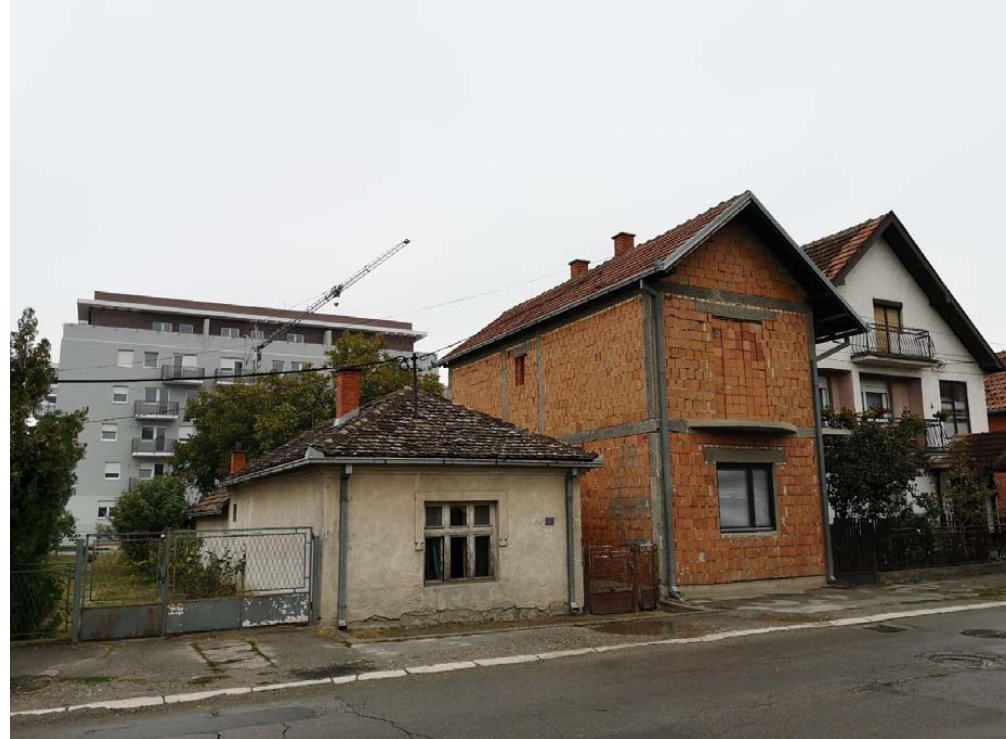
Figure 4. Variety of house construction in Ub—old house in the first row and a new building behind them (source: own photo). them (source: own